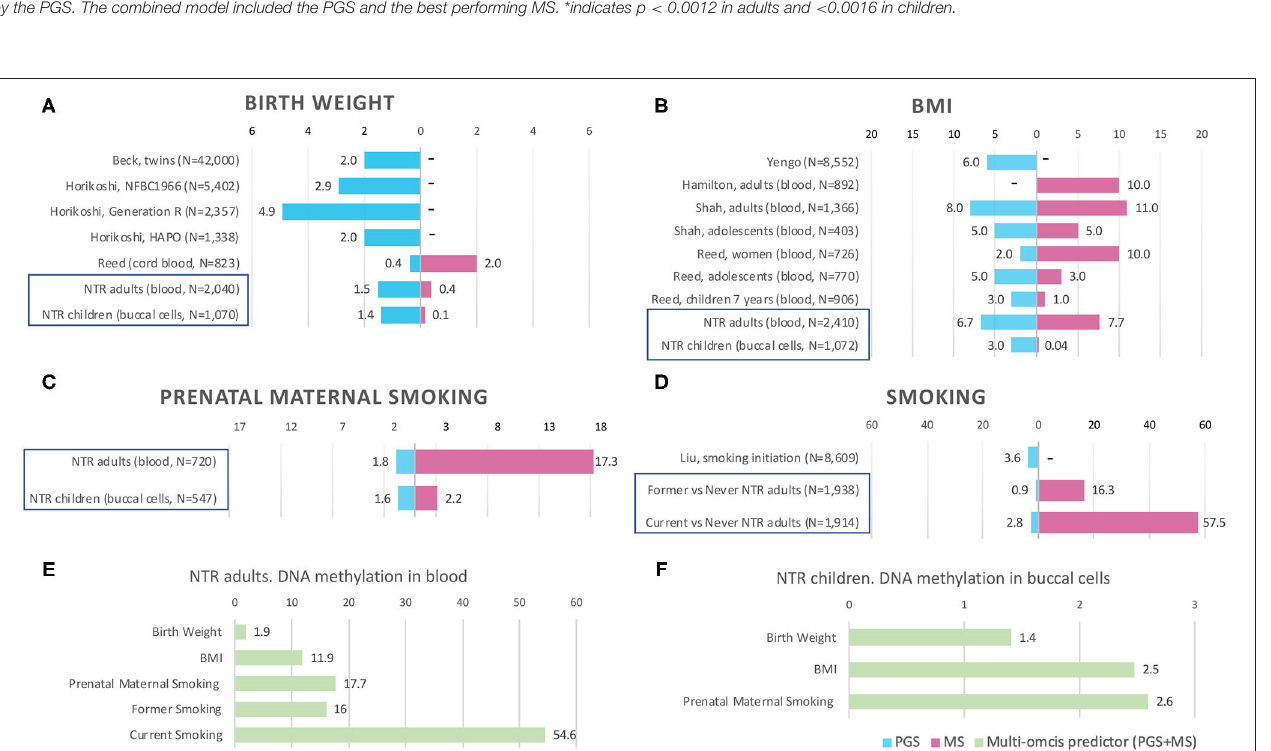
Smoking former vs. never